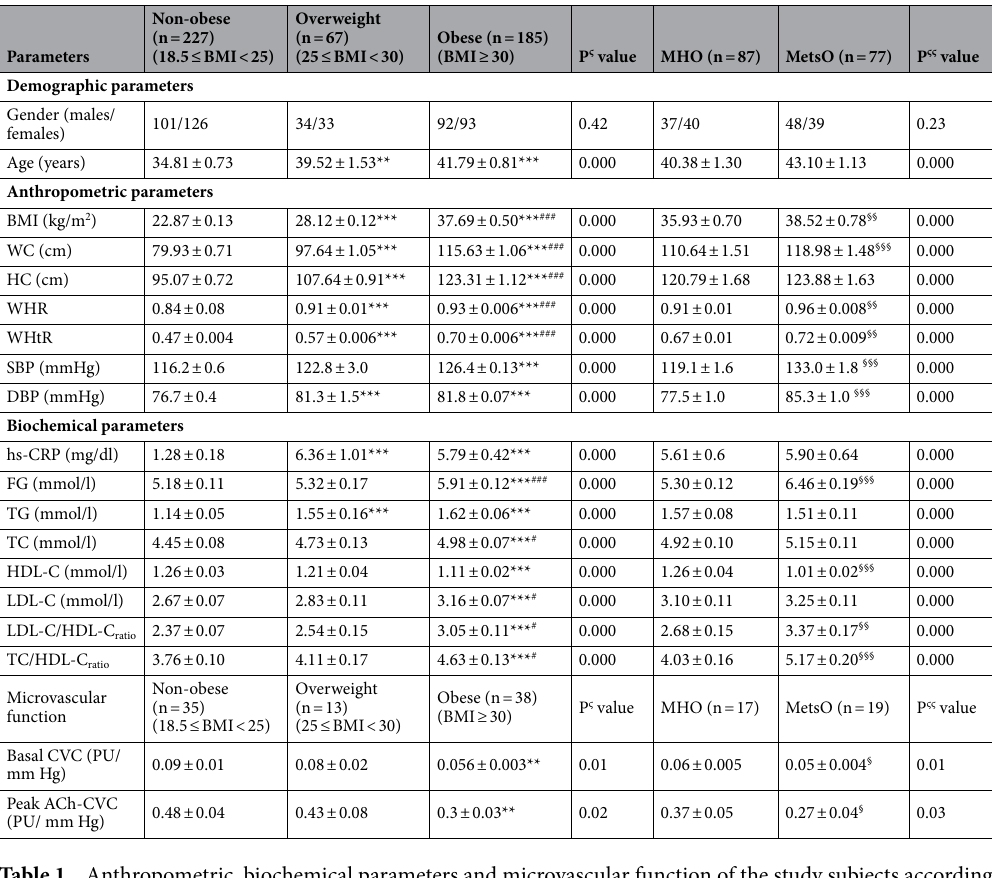
Table 1. Anthropometric, biochemical parameters and microvascular function of the study subjects according to obesity status. Data are presented as mean ± SEM. P ϛ indicates statistical differences intergroups (non-obese, overweight and obese subjects). P ϛϛ indicates statistical differences intergroups (non-obese, MHO and